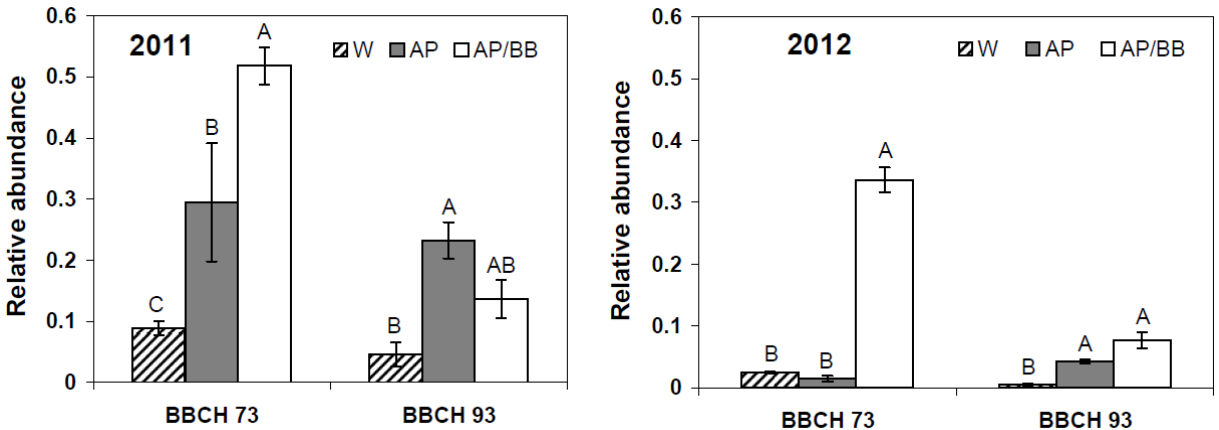
Figure 7. Relative abundance of ITS rRNA sequences assigned to the genus Aureobasidium in strawberry leaf samples at BBCH 73 (after four BCA applications) and BBCH 93 (four weeks after the last BCA application) as influenced by treatments with Aureobasidium pullulans as a single treatment (AP) or co-inoculated with Beauveria bassiana (AP/BB) in 2011 and 2012. The control (W) was treated with water from a lotic reservoir. Error bars represent SEM values. Columns marked with the same letters are not significantly different within each phenological stage ( α =